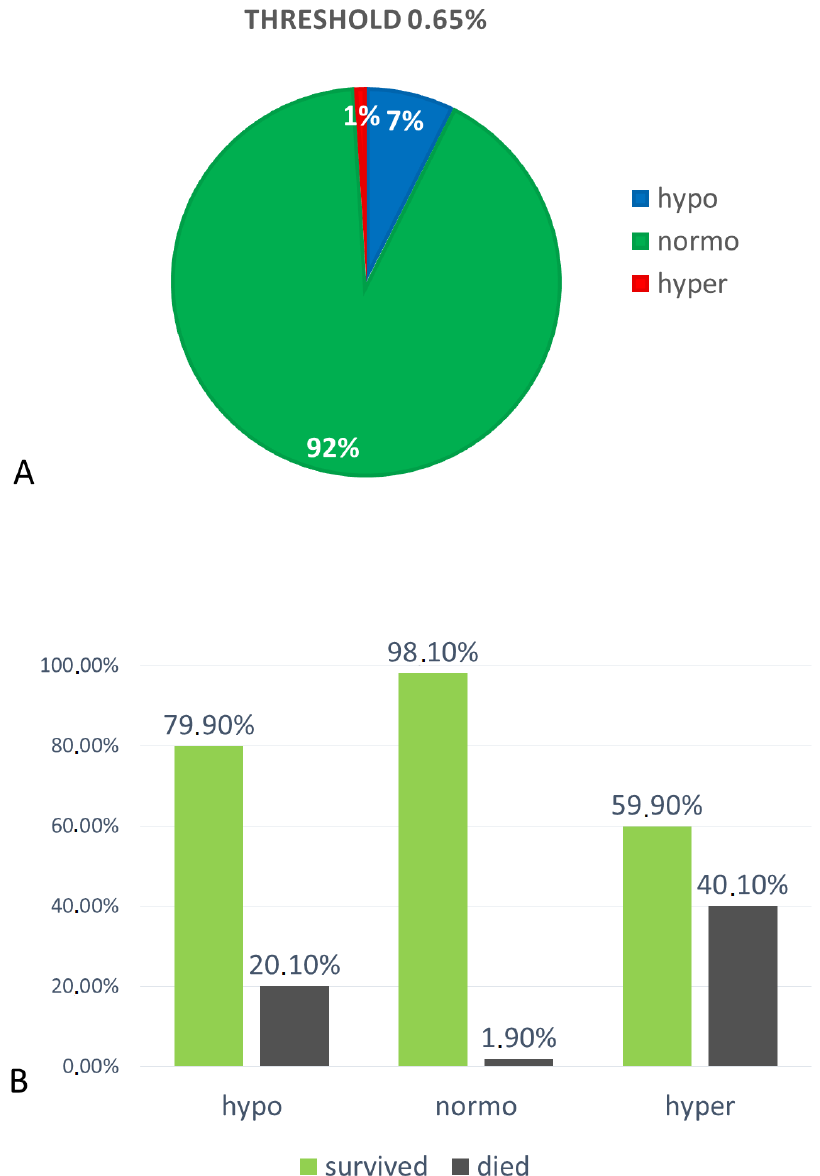
Figure 1. ( A ) Percentages of subjects assigned to hypo-, normo- and hyper-magnesemia groups at reference values of 0.65–1.2 mmol/L, and ( B ) in-hospital mortality ratio among separated groups. The difference between death ratio is statistically significant (Chi-square test), p <